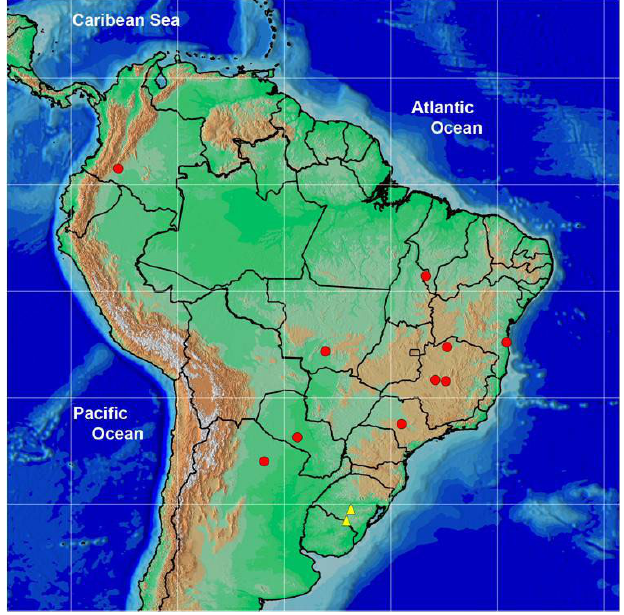
Fig 2 . Distribution map of Gracilidris pombero in the Neotropics. Known distribution: red circles. New records from Rio Grande do Sul, Brazil: yellow